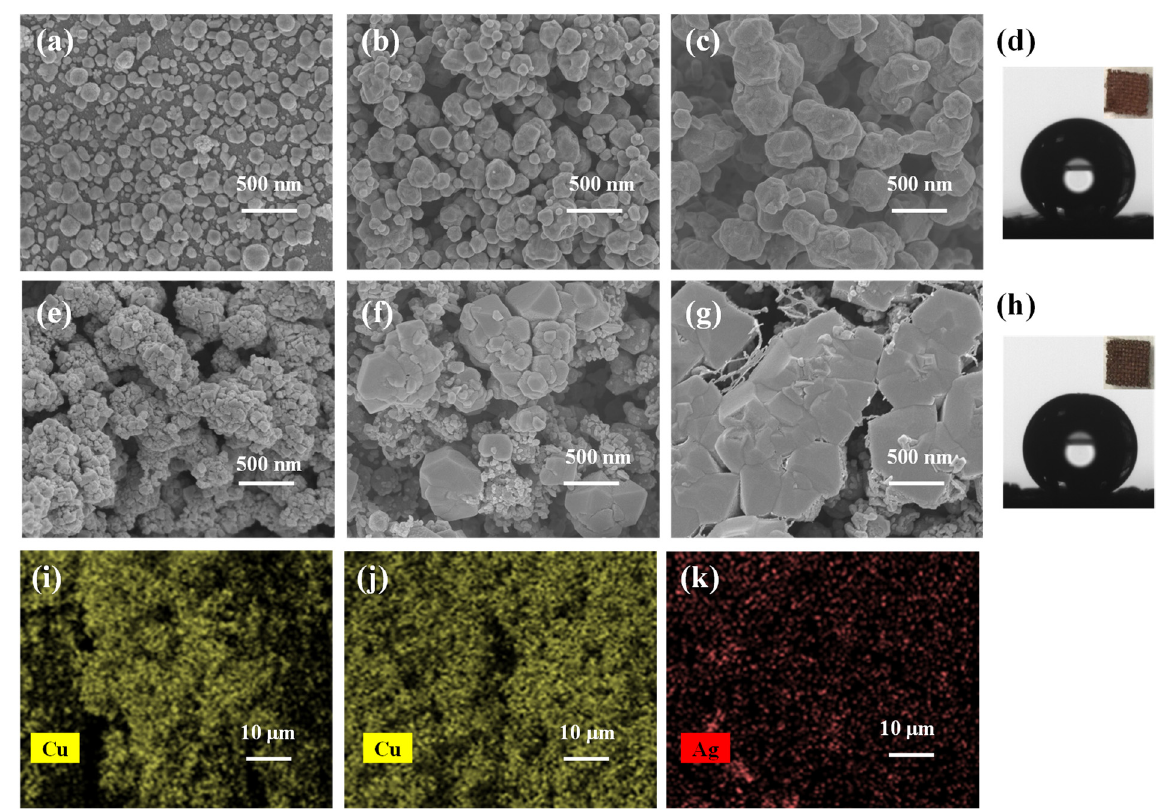
Figure 1. Characterization of Cu and Cu-Ag chips. ( a – c , e – g ) SEM images of the Cu coating with Table 1. h, ( b ) 6 h, ( c ) 12 h and Cu-Ag coating with the replacement time of ( e ) 1 min, ( f ) 3 min and ( g ) 5 min. ( d , h ) Contact angles of the coatings of 6 h Cu ( d ) and 6 h Cu-1 min Ag ( h ) on the fabric together with their photos in the inset. ( i ) EDS mapping of Cu on the Cu coating. ( j , k ) EDS mapping of Cu ( j ) and Ag ( k ) on the Cu-Ag coating. Table 1. Comparison between copper-based SERS chips prepared by various methods. SERS